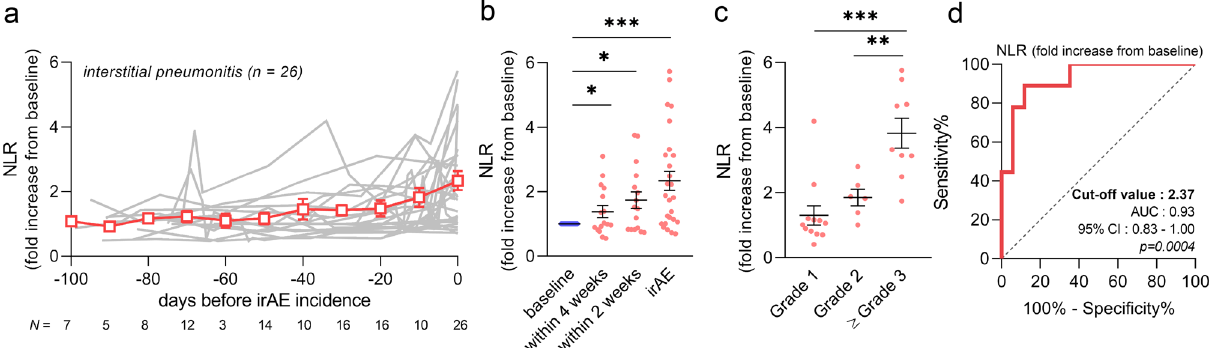
Figure 2. NLR trends in patients with interstitial pneumonitis. ( a ) Plotting the NLR trends during 100 days before development of ICI-related interstitial pneumonitis. The gray line indicates the individual patients (n = 26), and the red line shows the mean ± SEM. At 0 day is the initial detection of pneumonitis. ( b ) The NLR was significantly elevated not only at incidences of pneumonitis, but also 4 and 2 weeks in advance. ( c ) NLR elevation at pneumonitis development was compared among the severity of the irAEs. ( d ) ROC curve analysis of the sensitivity and specificity of NLR elevation from baseline to distinguish between Grade 1 or 2 and Grade 3 or higher pneumonitis (sensitivity 88.9%, specificity 88.2%, cut-off 2.37, p = 0.0004). Statistical analysis included one-way ANOVA with mixed-effects model followed by Holm-Sidak’s post hoc test ( b ), and one-way ANOVA with Tukey’s post hoc test ( c ). Data are shown as the mean ± SEM ( b , c ), * p < 0.05, ** p < 0.01, and *** p < 0.005. NLR neutrophil-to-lymphocyte ratio, ICI immune checkpoint inhibitor, irAE immune-related adverse event, ROC receiver operating